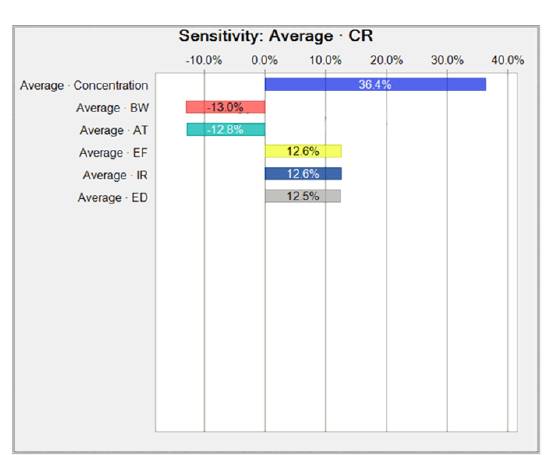
Figure A1. SA of LTCR model (adults) for As in water.